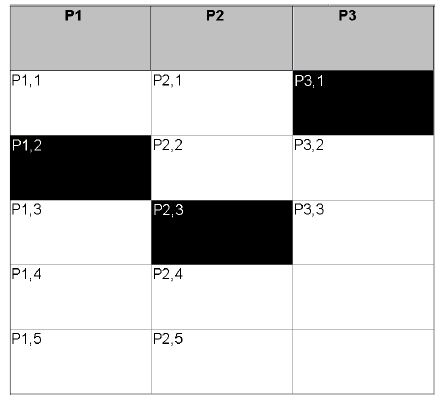
Figure 2: A three parameter morphological field containing 75 possible configurations, one